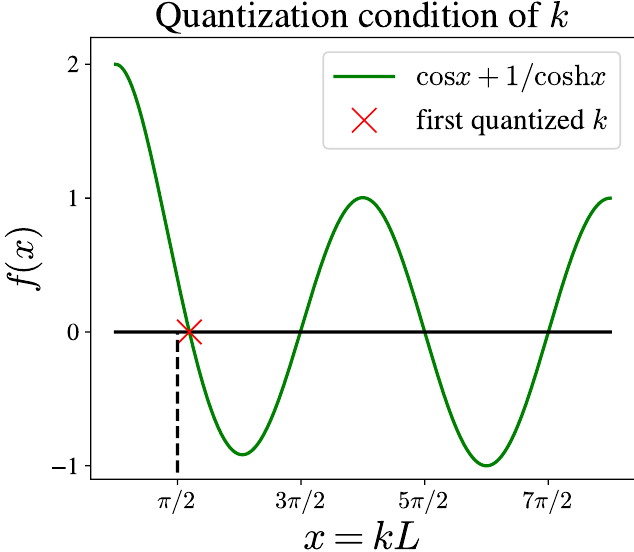
Figure 3: (Color online) Plot of the quantization condition in Eq. 7. The green curve plots the function f ( x ) = cos x + 1 / cosh x with x = kL . Intersections between f ( x ) and x -axis determine quantized values of k . The first quantized value, located around (cid:39) 1.875, is marked by a red cross. This value deviate from the first quantized value x 0 in Ising CFT, π/ 2. Quanlitatively, the order of the amplitude J can be aruged from this deviation: the deviation in the spectrum level is given by x 2 is the order of J